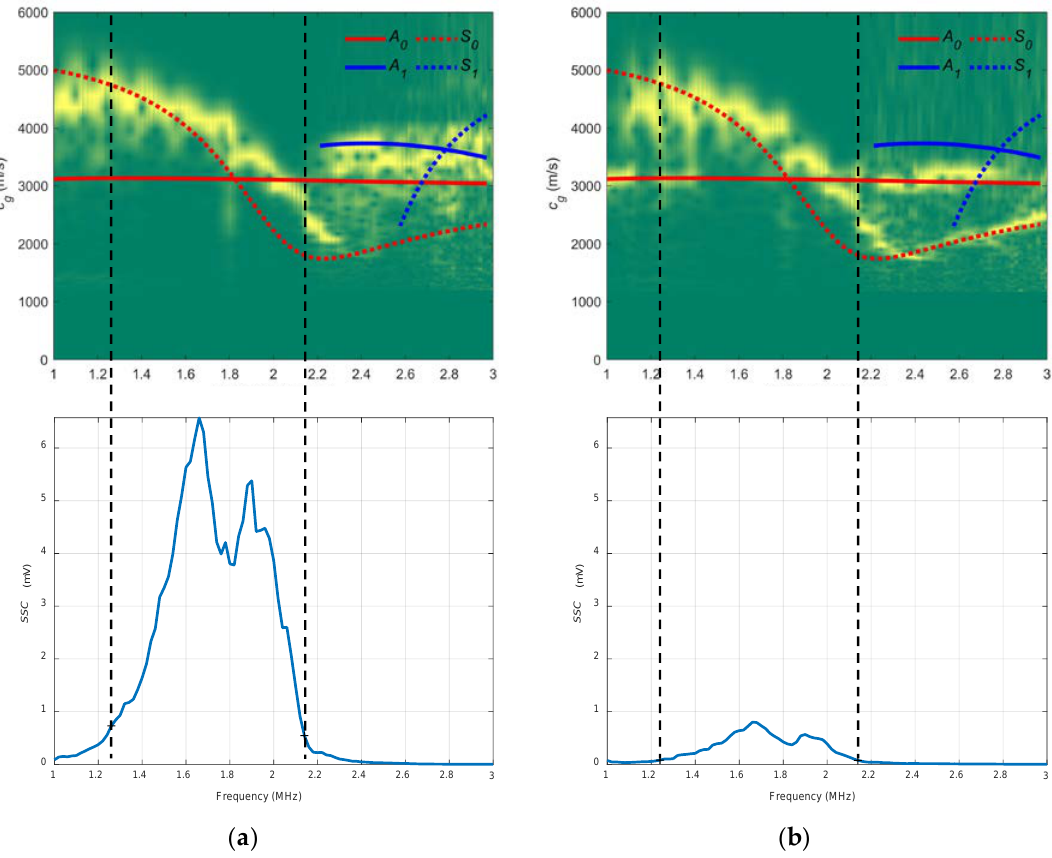
Figure 7. Combined spectrograms and system sensitivity curves ( SSC ) from the contact technique setup to measure the stainless steel plate: ( a ) 32°; ( b ) 50°.